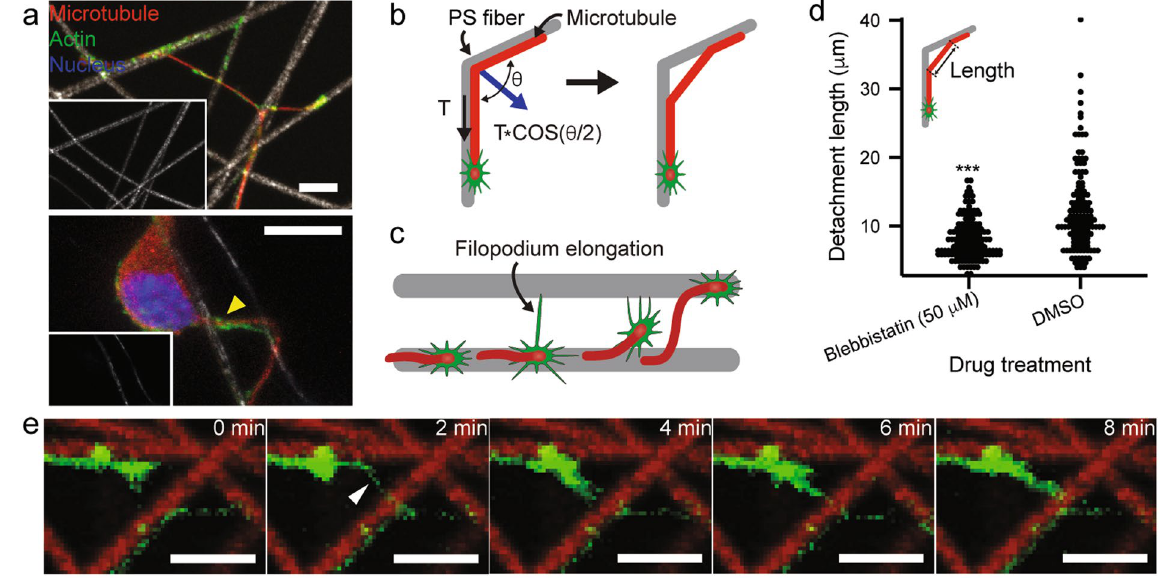
Figure 3. ( a ) Immunofluorescence images of 5 DIV neurons on electrospun PS fiber mesh showing neurites hanging over fibers. Microtubules and actin filaments were labeled with tuj1 (red) and phalloidin (green), respectively (scale bar: 10 μ m). ( b ) and ( c ) Two proposed scenarios on neurite detachment from the fibrillary substrate via growth cone’s traction force and filopodium elongation. ( d ) Comparison of the length of detached neurite from the underlying fiber between 50 μ M blebbistatin- and DMSO-treated (control) neurons. The average diameter of used PS fibrillary scaffold is 2.3 μ m and the detached neurite length was extracted from the fluorescence microscopy images of neurons (5 DIV) immunostained with tuj1 ( *** P < 0.001, the total cell number is 150 for each condition). ( e ) A series of time-lapse confocal microscopy images of actin-GFP expressing mouse hippocampal neuron (green) and confocal reflection microscopy-revealed electrospun fibers (red) (scale bar: 10 μ